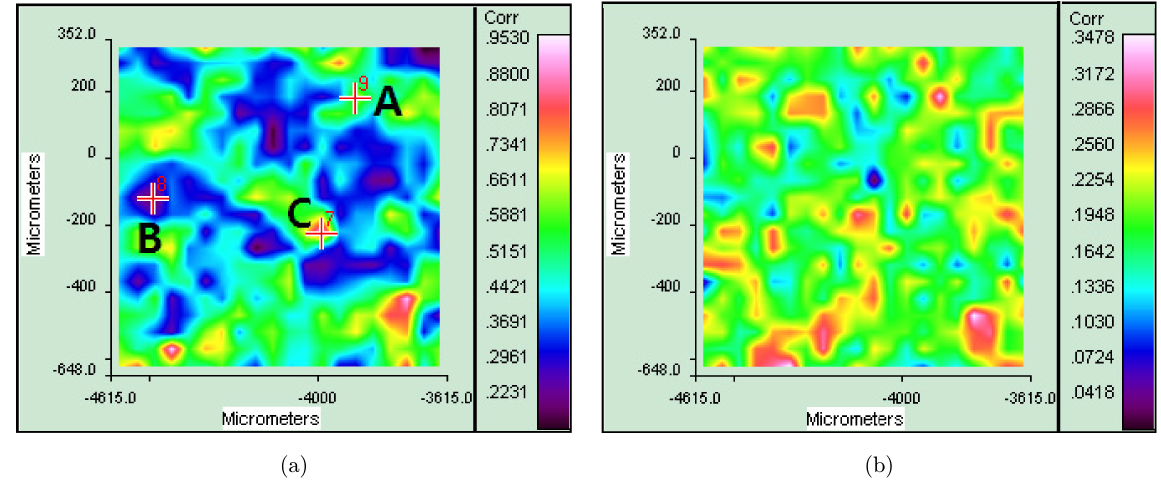
Fig. 2. Nifedipine near-infrared spectral images correlation coe±cient of sample No. 23 (a) and sample No. 39 (b), with correlation